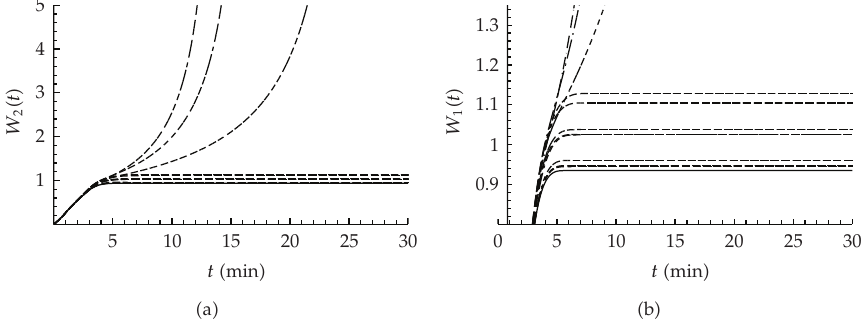
Figure 7: W 2 (cid:4) t (cid:7) evaluated for optimal distribution coe ffi cients (cid:4) continuous line (cid:7) and random choices (cid:4) dashed lines (cid:7) . (cid:4) a (cid:7) evolution in (cid:5) 0; T (cid:6) . (cid:4) b (cid:7) zoom around the asymptotic optimal values.